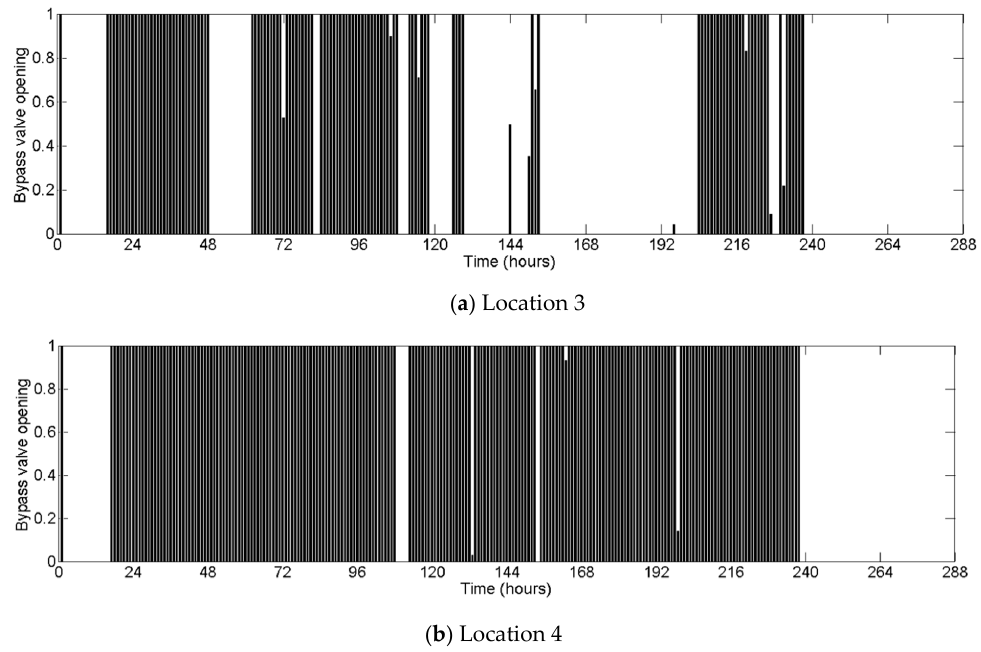
Figure 12. Operational scheduling for the bypass valves of the two NC 150–200 turbines installed at locations 3 and 4.